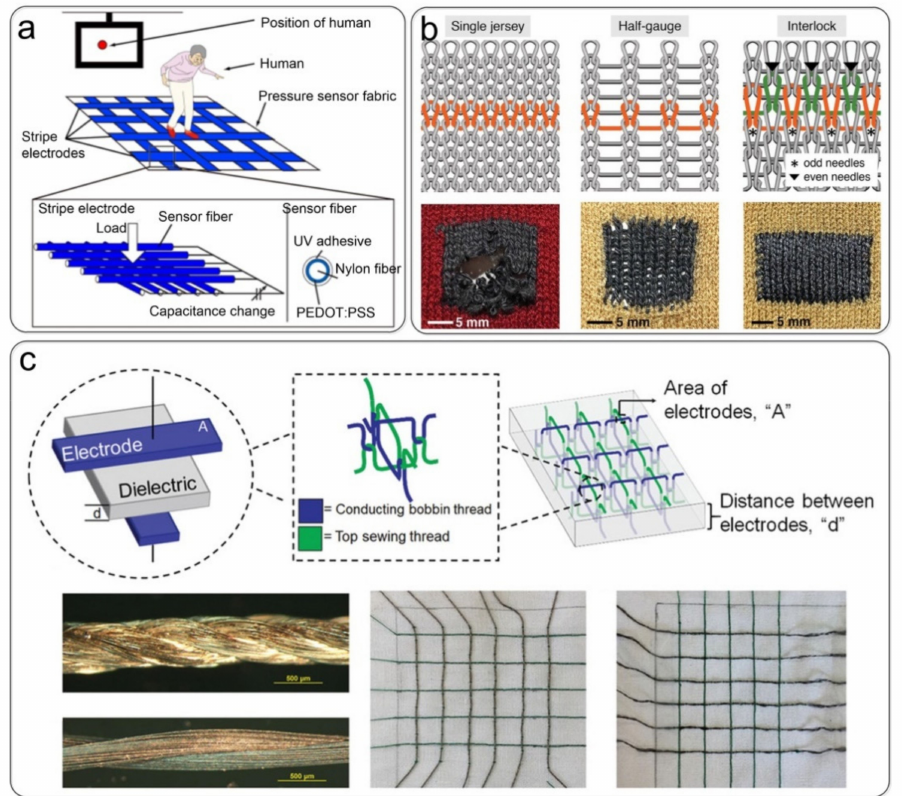
Figure 4. Fabrication of a capacitive pressure sensor by weaving technology. ( a ) Vertically stacked strip fabric electrodes of conductive polymer-coated fibers. Reprinted with permission from Ref. [118]. Copyright 2015 Springer Nature. ( b ) Different knitting patterns of multifunctional MXene-coated cellulose yarns. Reprinted with permission from Ref. [99]. Copyright 2019 Wiley-VCH. ( c ) Seam-line sensor network produced with silver threads. Reproduced with permission Ref. [130].